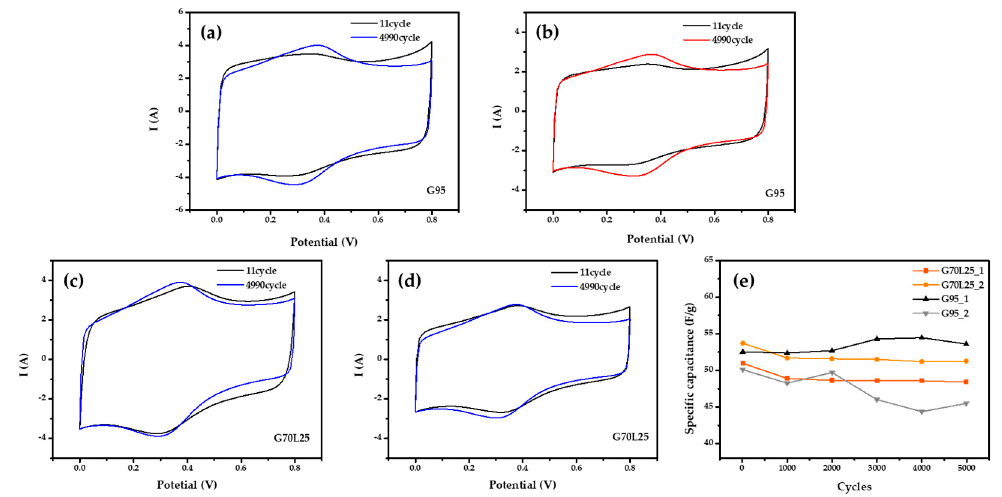
Figure 6. Cyclic voltammetry at 20 mV/s ( a ) specific capacitance decreased after 4990 cycles for the electrode of G95 in 1M H 2 SO 4 ; ( b ) specific capacitance increased after 4990 cycles for the electrode of G95 in 1 M H 2 SO 4 ; ( c , d ) specific capacitance decreased after 4990 cycles for the electrodes of G70L25 in 1 M H 2 SO 4 ; ( e ) the plot of specific capacitance verse cycle at 20 mV/s in H 2 SO 4.